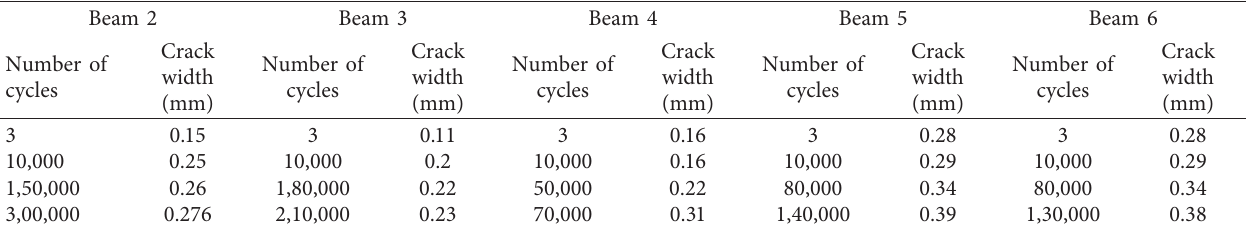
Table 5: The number of cycles and corresponding crack width.